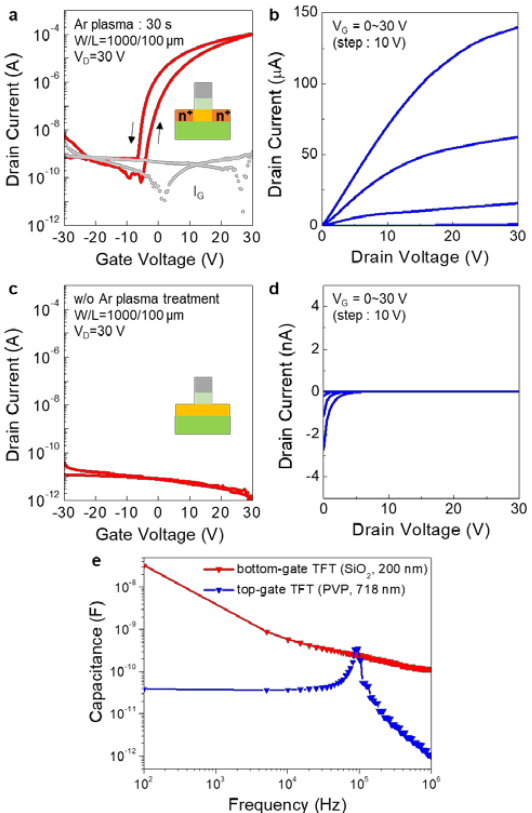
Figure 4. ( a ) Transfer and ( b ) output characteristics of self-aligned top-gate IGZO TFTs fabricated with Ar plasma treatment time of 30 s. The channel width and length were 1000 and 100 µm, respectively. ( c ) Transfer and ( d ) output characteristics of self-aligned top-gate IGZO TFTs fabricated without the Ar plasma treatment. In this case, the TFTs showed no switching behavior. ( e ) Capacitance-frequency data obtained from bottom-gate IGZO TFTs using SiO 2 gate dielectric (thickness ~200 nm) and top-gate IGZO TFTs using PVP gate dielectric (thickness ~718 nm).